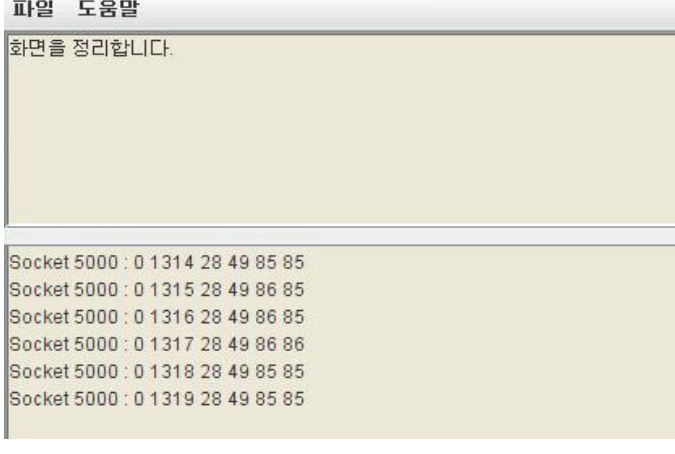
Figure 16. Screen that Receives Data Sent by Another Server